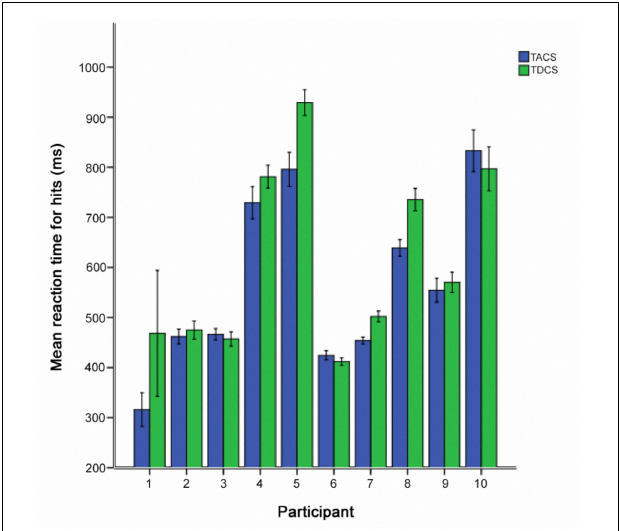
FIGURE 6 | Individual post-stimulation reaction times for hits, comparing stimulation type for participants receiving sham-stimulation in the first session ( N = 10). Error bars represent one standard error of the